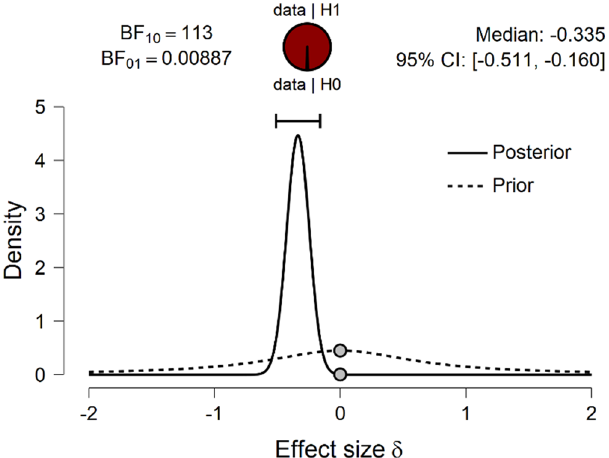
Figure 3. Two tailed t test results for odor identification (I) change in the whole group. The probability wheel on top demonstrates the evidence that the data provide for the two rival hypotheses. The two gray dots specify the prior and posterior density at the test value. The median and the 95% central credible interval of the posterior distribution are presented in the top right corner 71